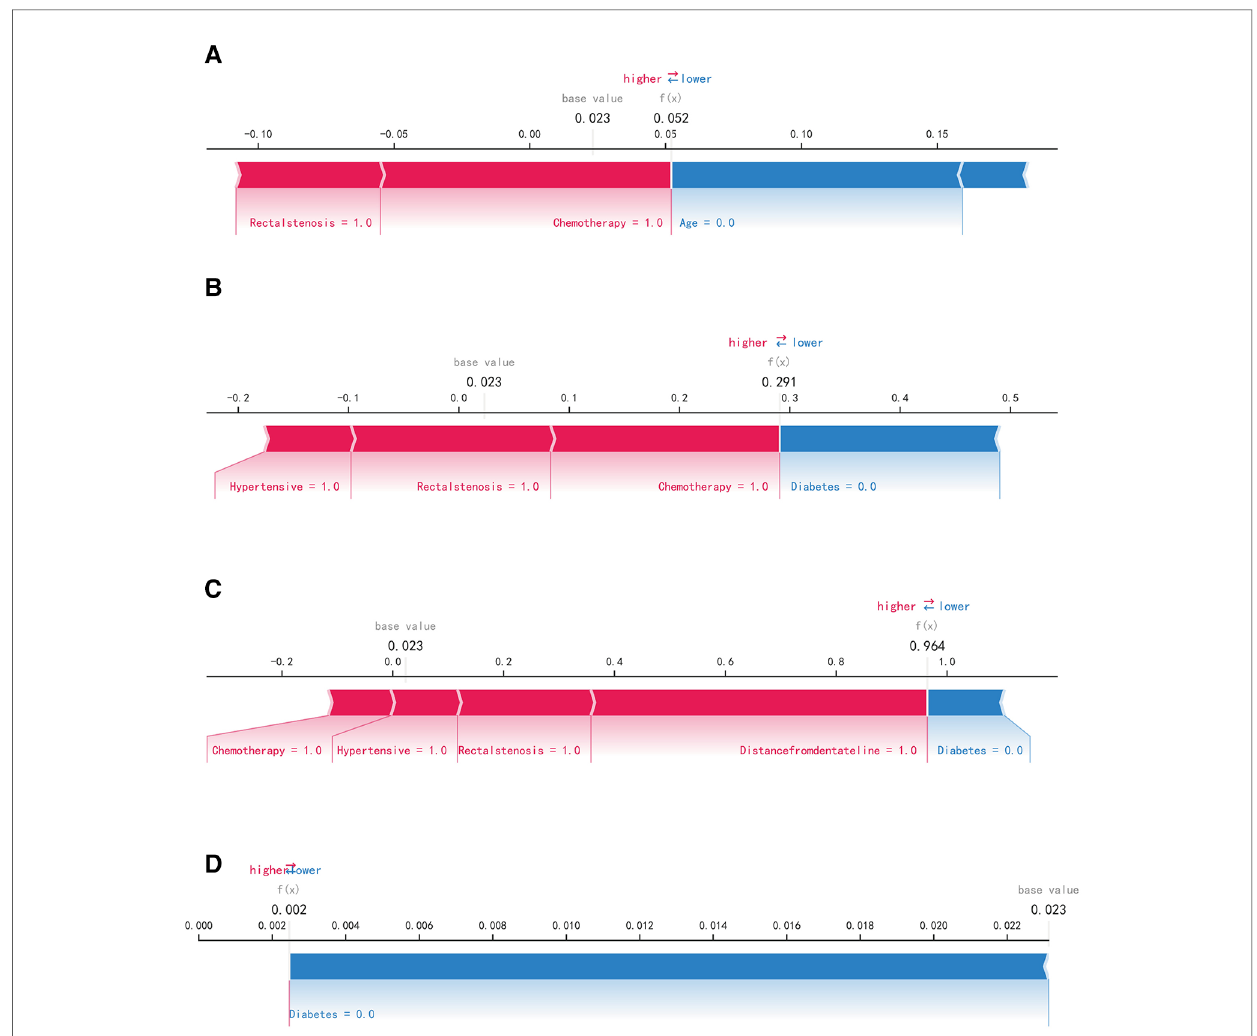
FIGURE 5 SHAP force plot. The contributing variables are arranged in the horizontal line, sorted by the absolute value of their impact. Blue represents features that have a negative effect on disease prediction, with a decrease in SHAP values; red represents features that have a positive effect on disease prediction, with an increase in SHAP values. ( A ) Predictive Analysis of Patient I. ( B ) Predictive Analysis of Patient II. ( C ) Predictive Analysis of Patient III. ( D ) Predictive Analysis of Patient